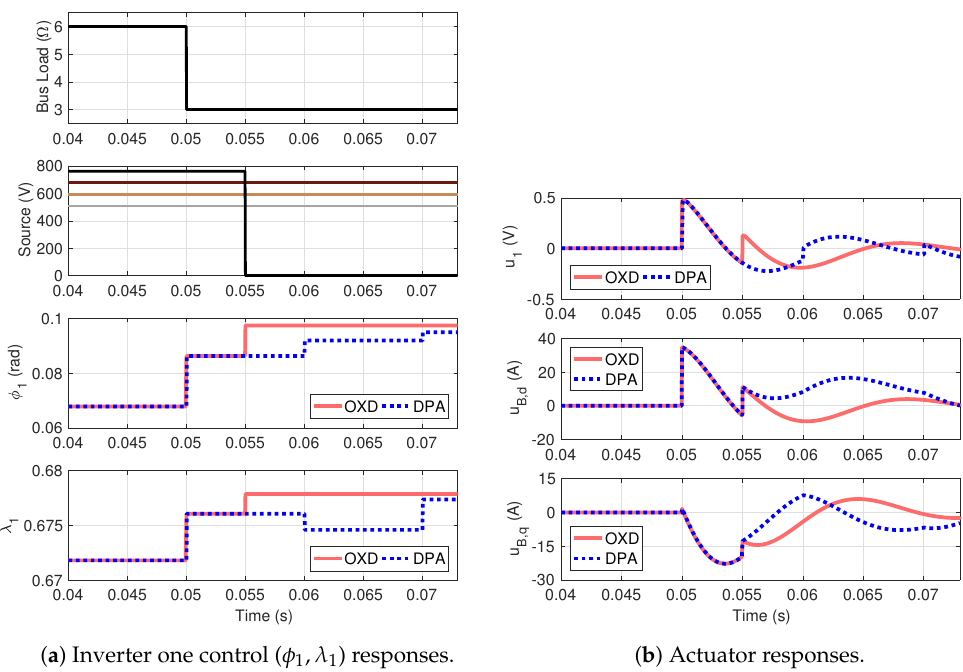
Figure 6. Scenario 2: OXD and DPA: ( a ) inverter one controls the ( φ 1 , λ 1 ) response and ( b ) controlled storage response to a bus load step at t = 0.05 s , followed by the largest inverter being eliminated from the microgrid at t = 0.055 s